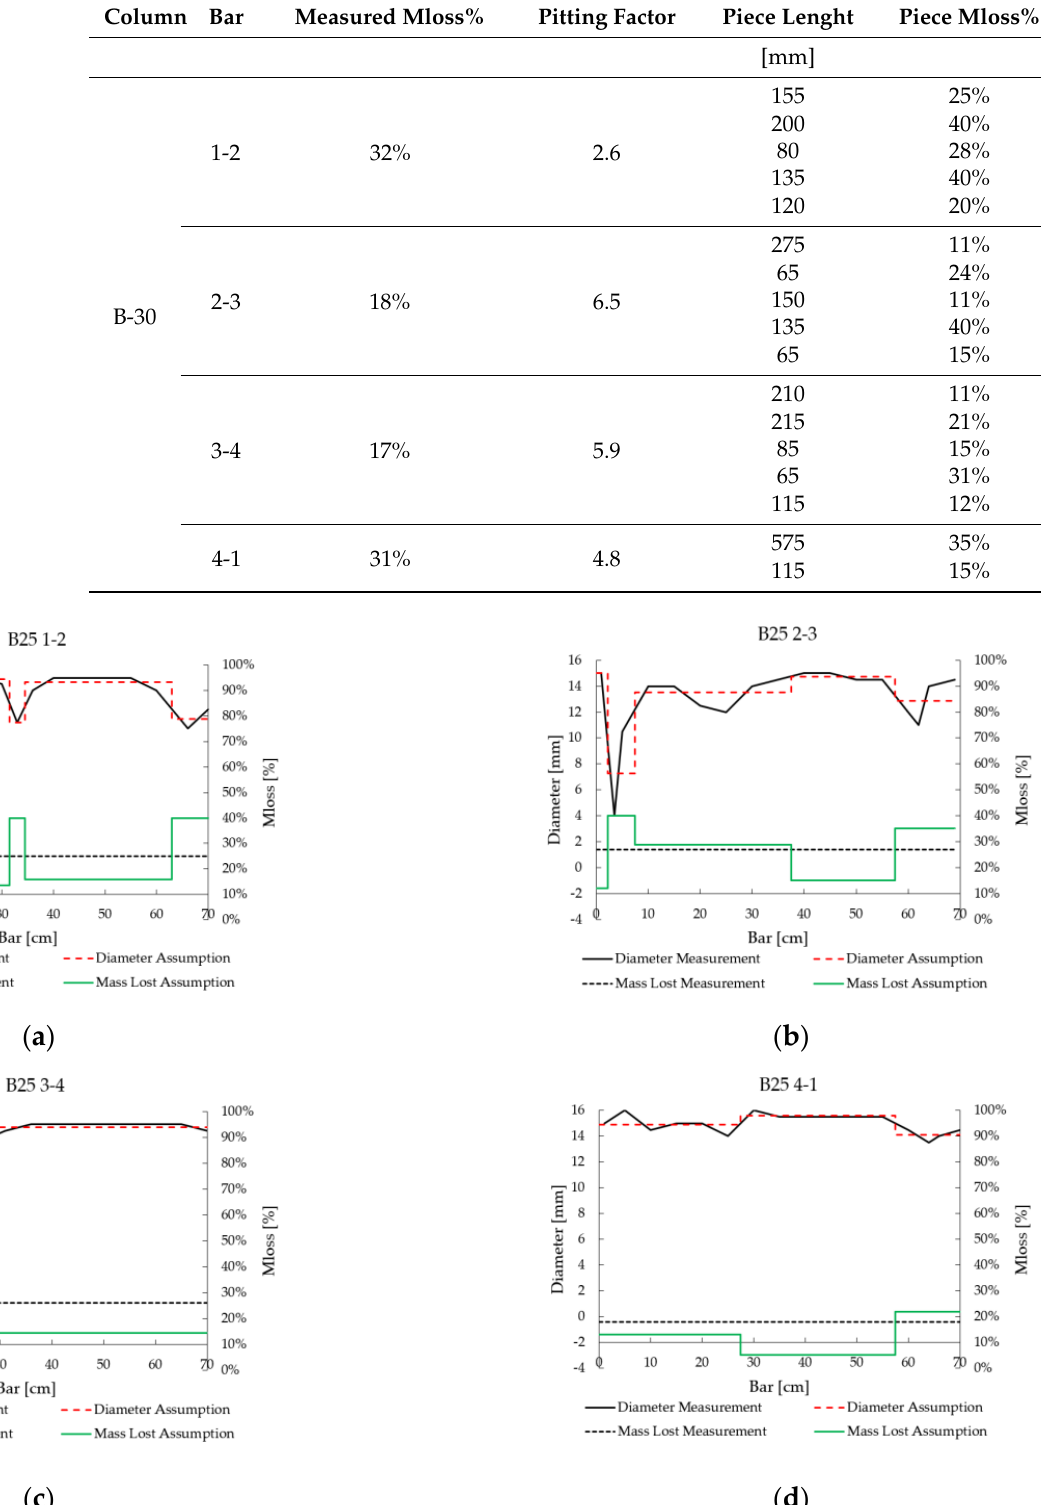
Table 6. Pitting factor and lost mass assumed for strategy 4, column B30.